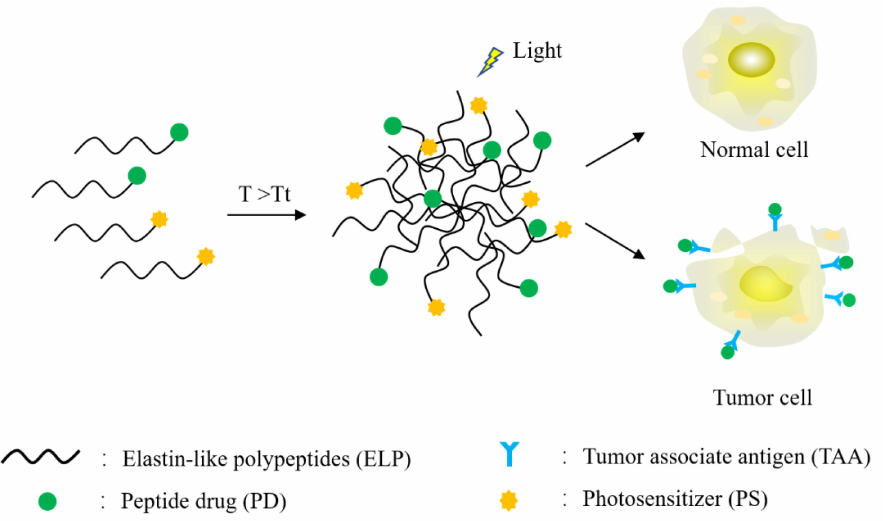
Figure 1. Schematic representation of photodynamic therapy using ELP-PS in combination with ELP-PD. T > Tt indicates that ELP aggregation occurs when the temperature is higher than the Tt; when stimulated by light, the aggregated ELPs release the